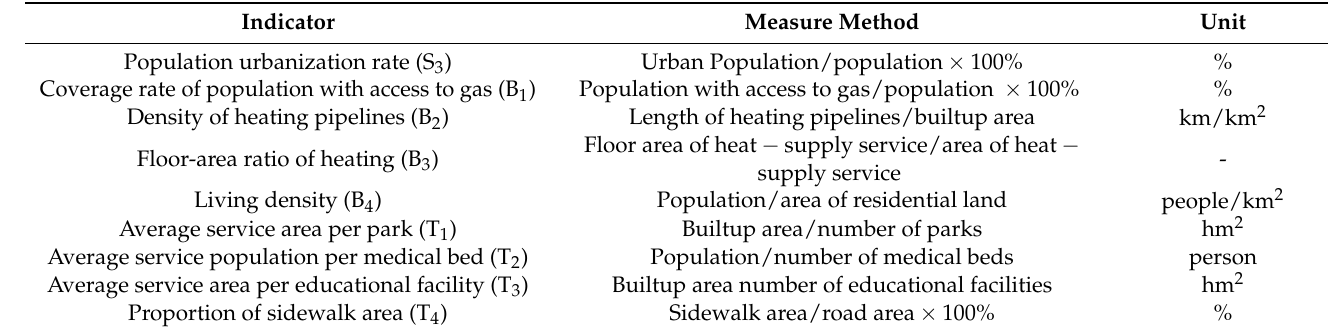
Table A1. Measurement methods of some